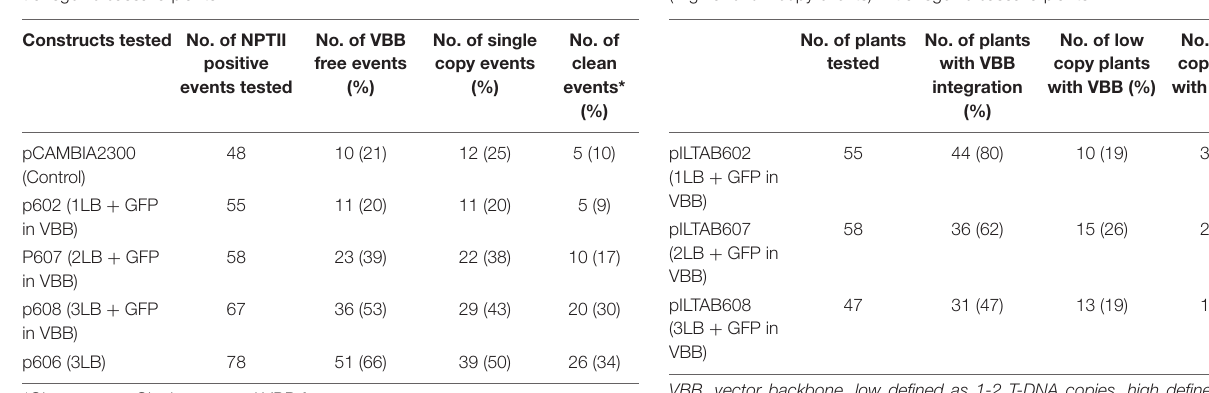
TABLE 3 | Frequency of vector backbone integration and T-DNA copy number (High and low copy events) in transgenic cassava plants.